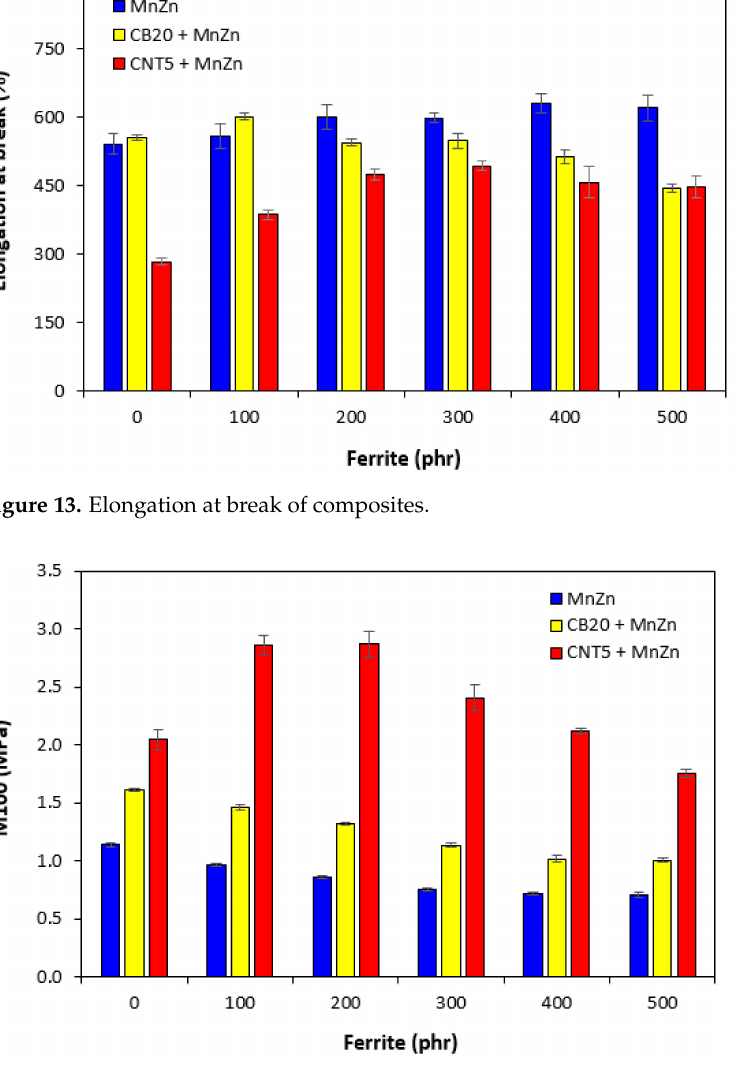
Figure 14. Modulus M100 of composites.